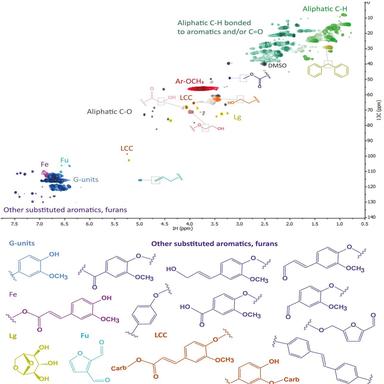
HSQC NMR spectrum of PL and main representative structures (solvent: DMSO-d6). (Ar−OCH3) Methoxy groups bonded to aromatics (Lg) Levoglucosan; (LCC) Lignin-carbohydrate bonds; (Fe) Ferulate; (Fu) Furans.